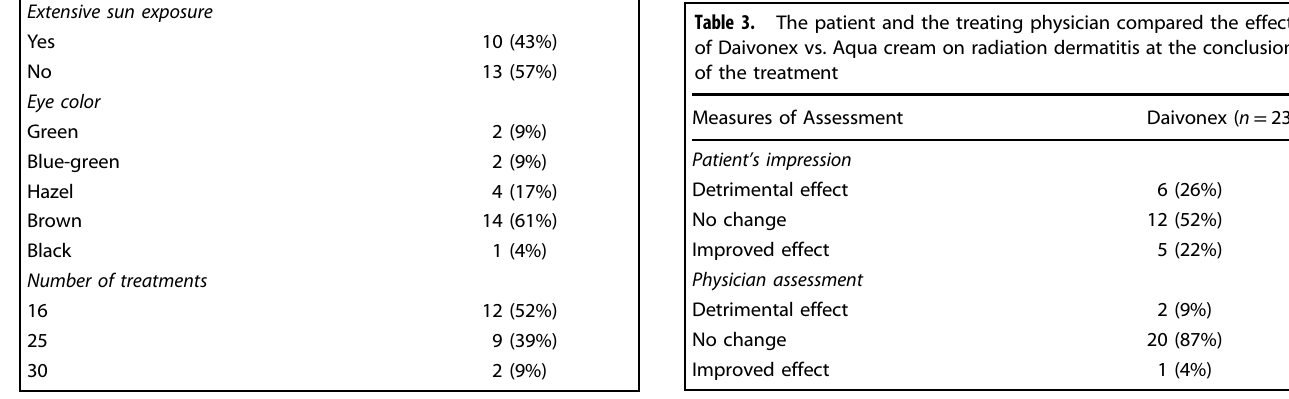
Table 3. The patient and the treating physician compared the